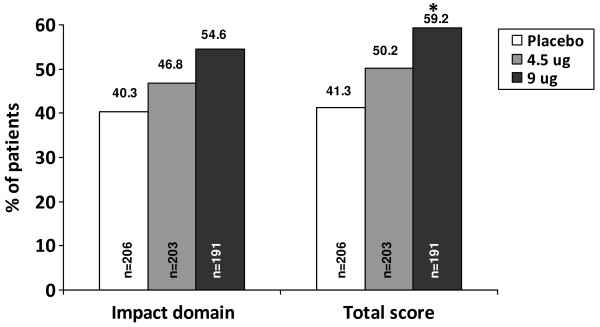
Percentage of patients with a SGRQ improvement rate > 4; *p < 0.001 vs. placebo.